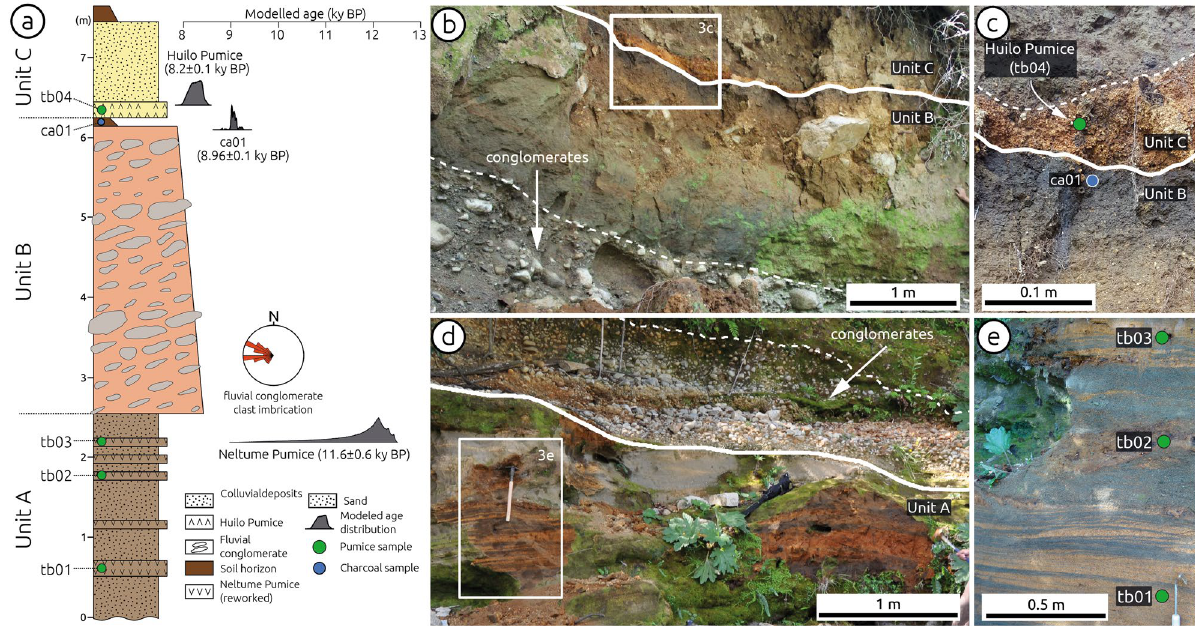
Figure 4. Stratigraphy and geochronology of terrace T2. ( a ) Composite stratigraphic section with units and location of pumice and charcoal samples. Grey probability density plots denote modelled age distributions for stratigraphic markers from OxCal model results (Supplementary Materials, Fig. S7). Rose diagram shows paleocurrent direction estimated from clast imbrication in unit B. Grey curves denote modelled age distributions (see text for details). ( b ) Field view of contact between units B and C. Note upward-fining transitional contact between conglomerate and paleosol (stippled white line), and sharp contact with Unit C (solid white line). ( c ) Detail of contact between units B and C (solid white line). Blue and green circles show sampling locations. Stippled white line marks top of Huilo pumice. ( d ) View of unit the contact between units A and B (thick white line) and of basal conglomerates in unit B. Stippled white line shows dipping layers of the conglomerates. ( e ) Detailed view of reworked Neltume pumice and black volcanic sand in unit A. Green dots show sampling locations. Photos reproduced with consent from copyright